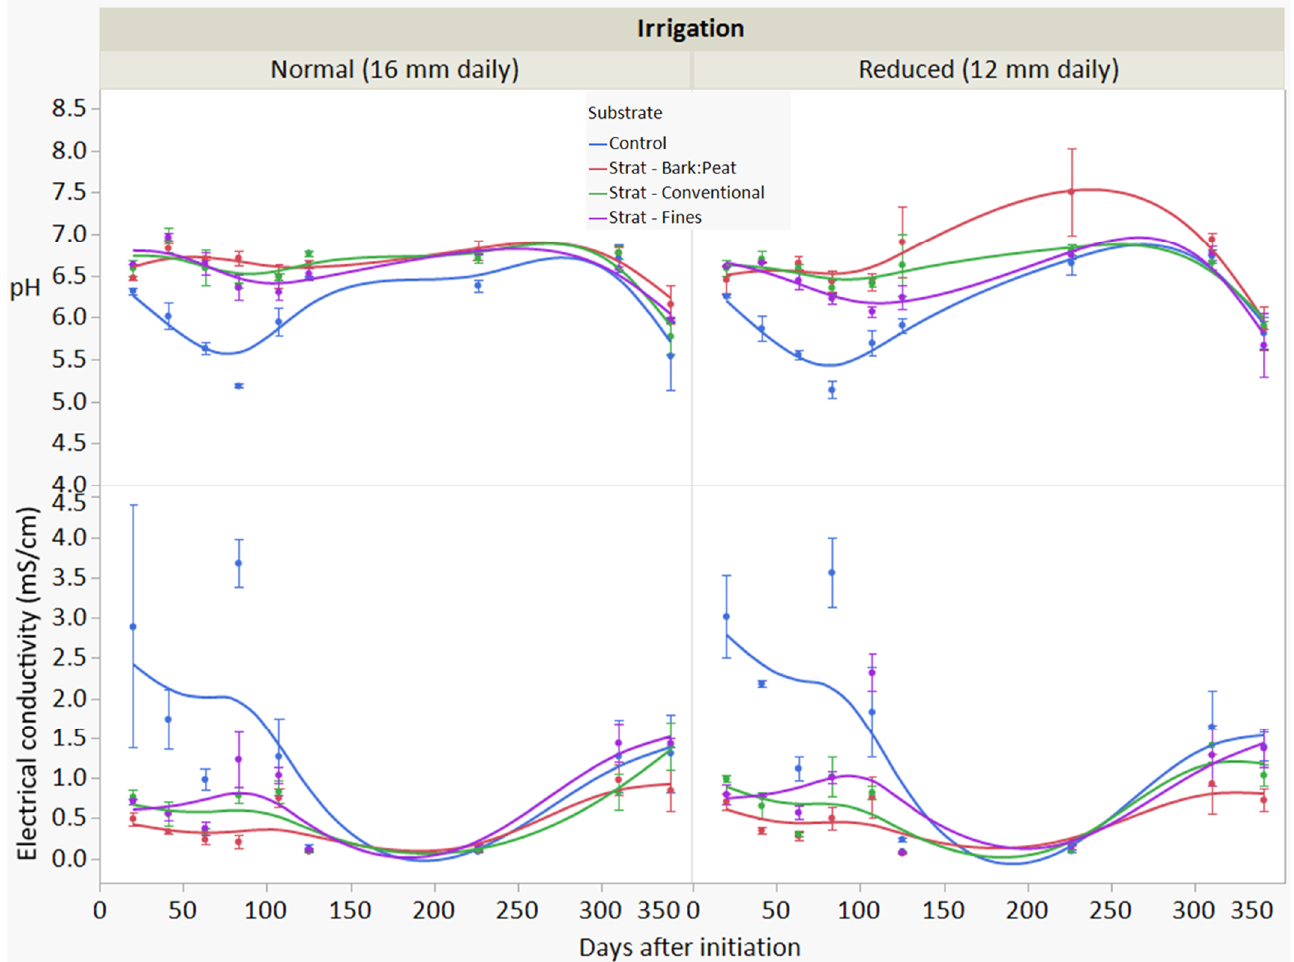
Figure 6. Pore water fertility assessed via pour-through analysis of Drift roses planted in a conventional pine bark substrate (control) or stratified substrates, in which either conventional pine bark substrate amended with 35% peat (by vol.; bark–peat), conventional pine bark (conventional), or fine pine bark (fines) was layered on top of a coarse screened pine bark. Plants were irrigated with 16 mm (normal; control) or 12 mm of water daily (reduced). Bars represent on standard error from the mean.